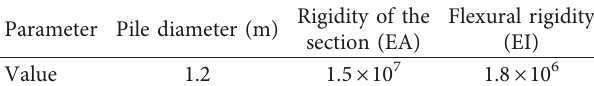
Table 7: Mechanical parameters of the pile row.